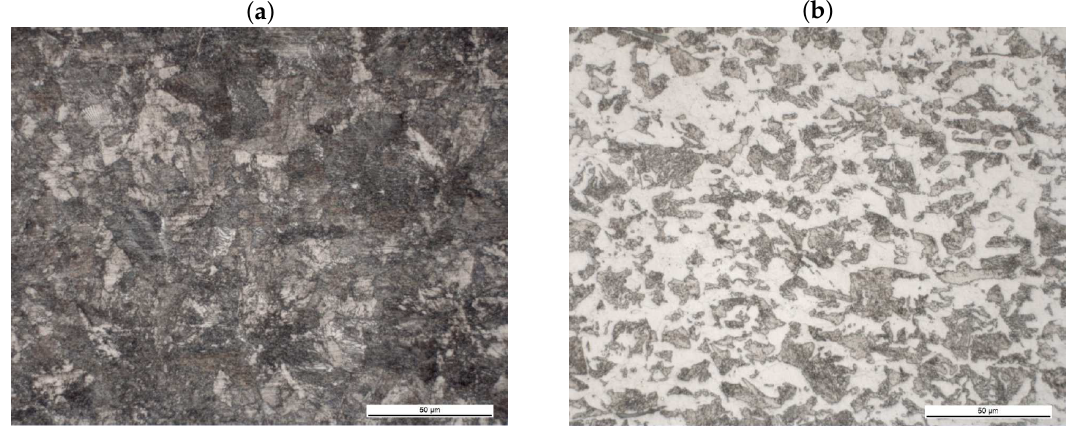
Figure 3. Microstructure of both materials in the longitudinal direction before testing. ( a ) Material 1 ( ε eng ≈ 0). ( b ) Material 2 ( ε eng ≈